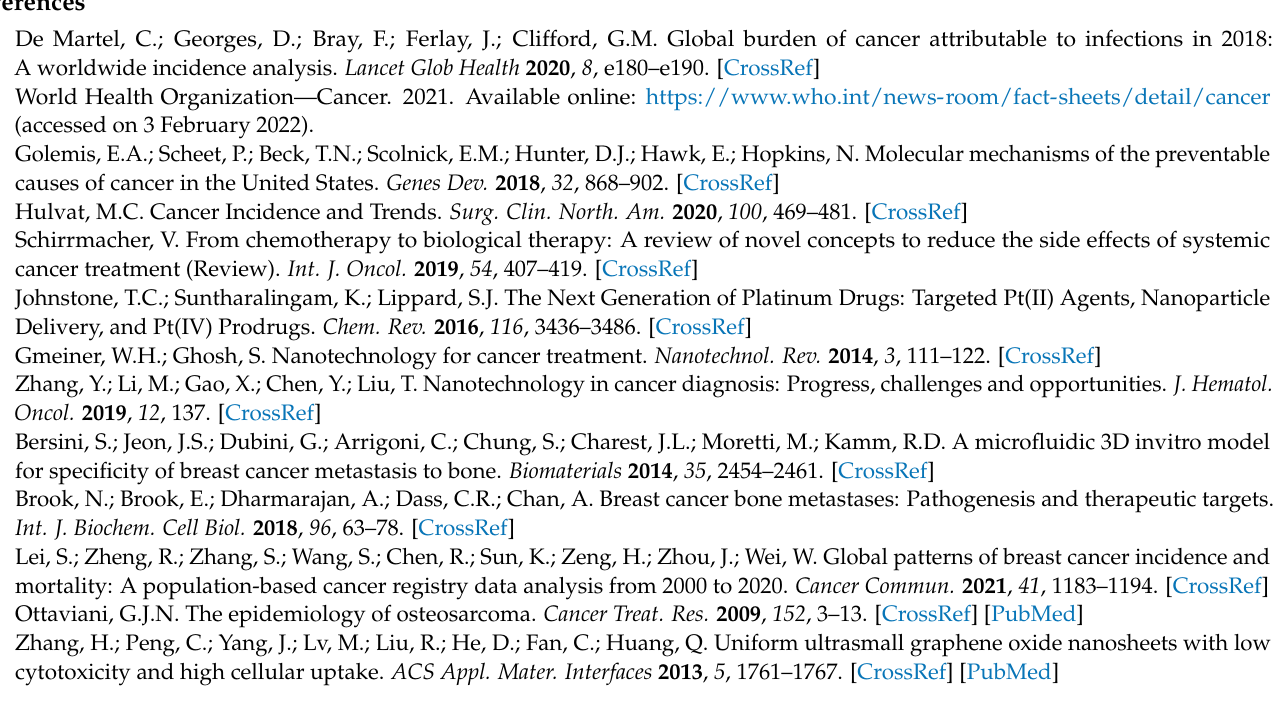
distribution of GO flakes. Figure S3: U2-OS cells’ morphology evaluation at 72 h; Figure S4.: MG63 cells’ morphology evaluation at 72 h; Figure S5. SAOS-2 cells’ morphology evaluation at 72 h; Figure S6. U87 cells’ morphology evaluation at 72 h; Figure S7. U118 cells’ morphology evaluation at 72 h; Figure S8. MDA-MB-231 cells’ morphology evaluation at 72 h; Figure S9. MDA-MB-468 cells’ morphology evaluation at 72